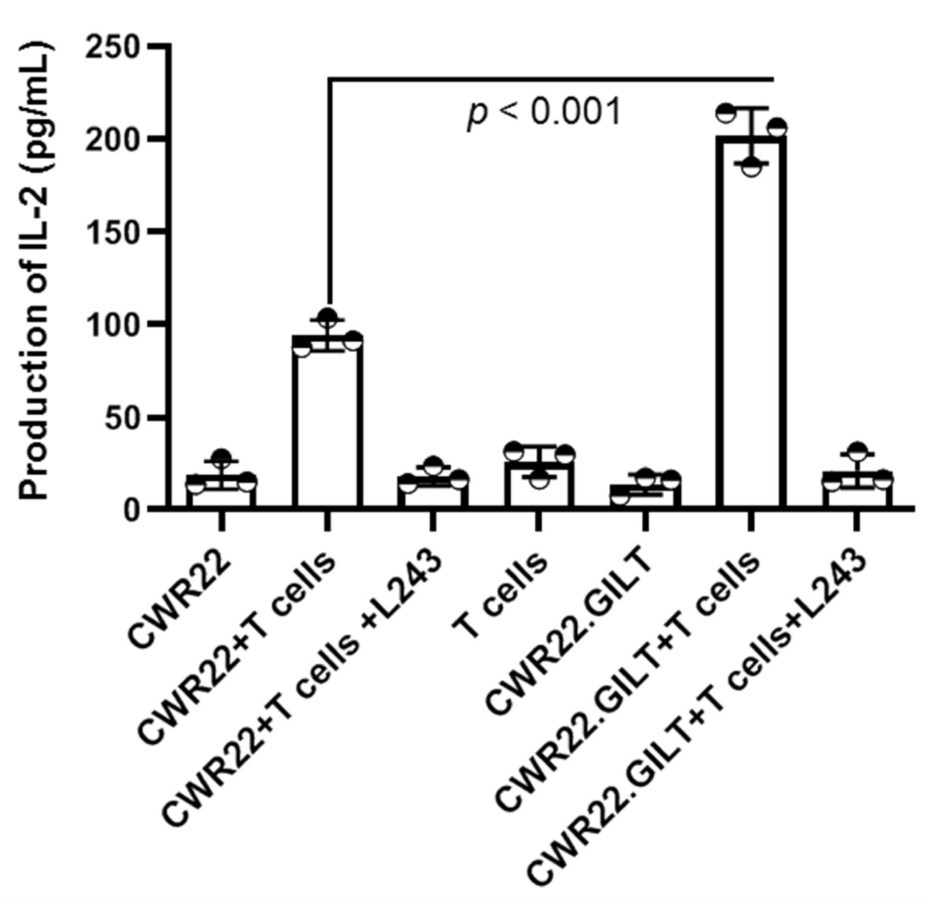
Figure 4. GILT expression enhances CD4 + T cell recognition of prostate cancer cells. HLA-DR- expressing prostate cancer cell lines CWR22Rv1.vec and CWR22Rv1.GILT were cocultured with PSMA-specific CD4 + T cells raised from an HLA-DR-positive healthy donor in the presence or absence of anti-class II antibodies (L243) for 48 h. Human IL-2 ELISA was performed to quantitate the amount of IL-2 present in the culture supernatant and was expressed as pg/mL. Data are representative of at least three separate